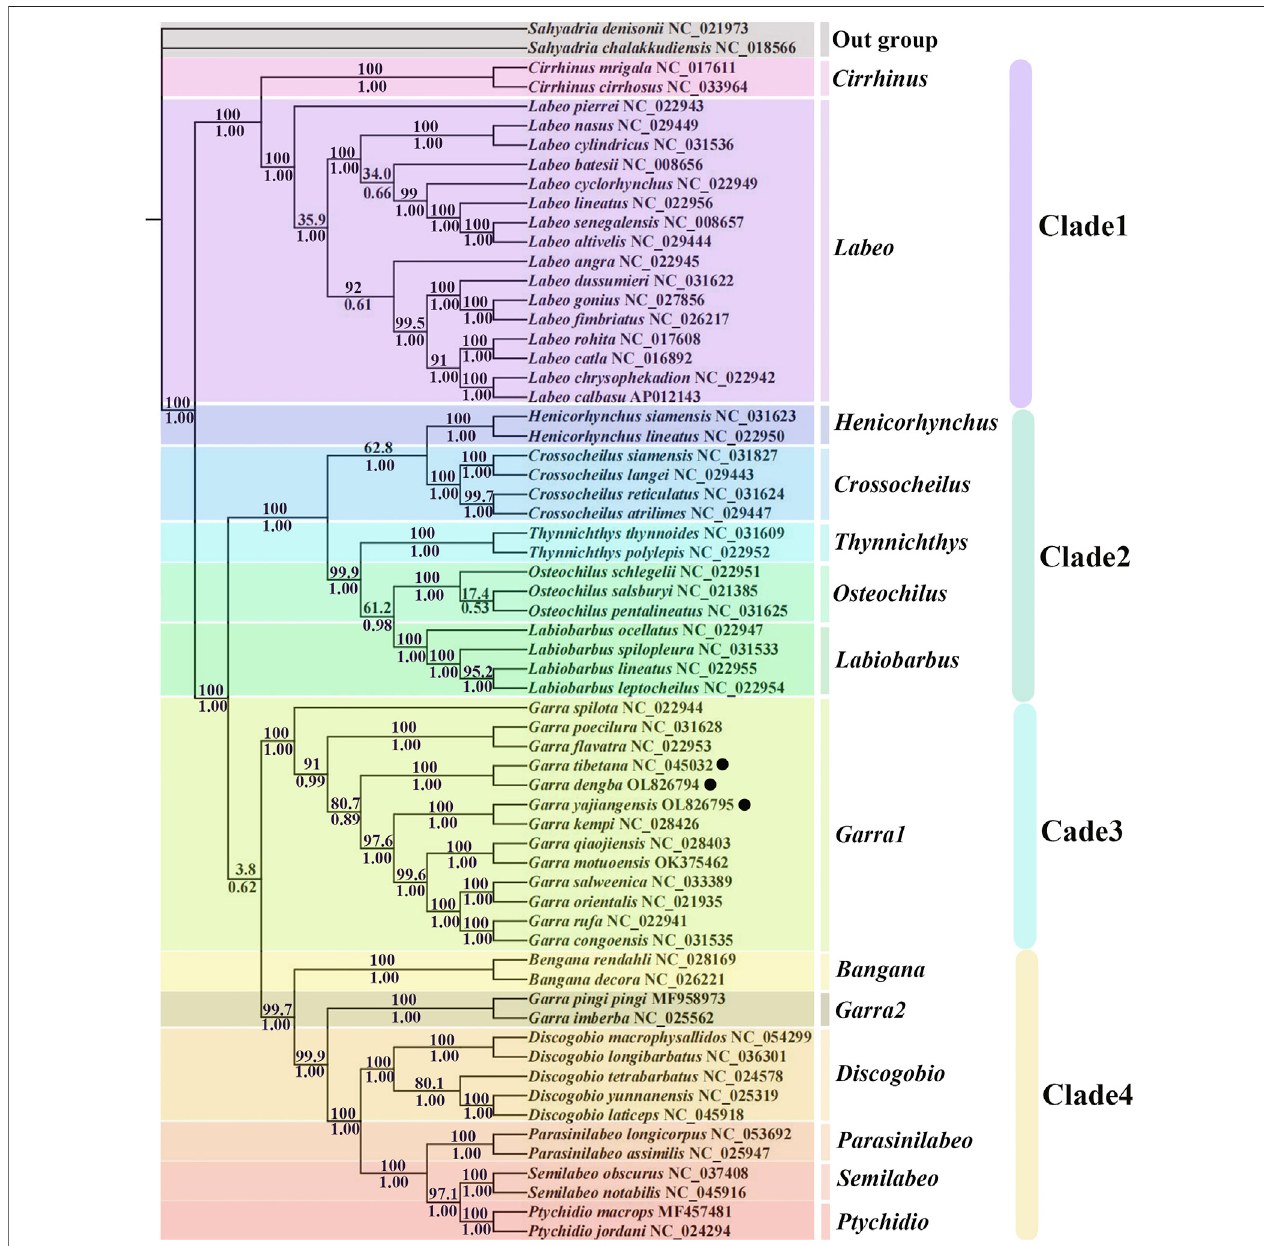
FIGURE 6 | Phylogenetic analysis is based on the nucleotide sequences of the 12 PCGs in the mitogenome. The numbers beside the nodes are posterior probabilities (BI, bottom) and bootstrap (ML, top). Black point: gene rearrangement occurs.